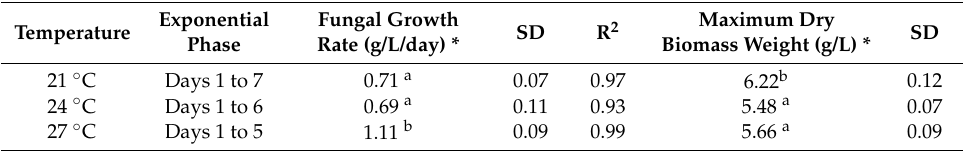
Table 1. Biomass growth rates and final dry biomass weights based on temperature of growth for T.